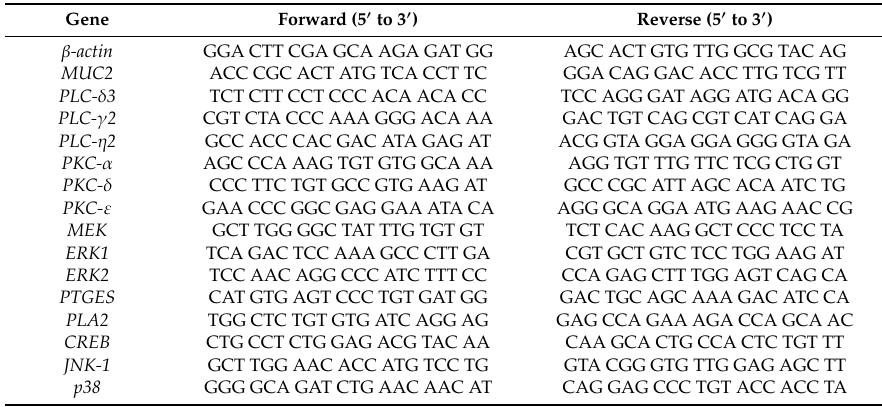
Table 1. Primers used for qPCR